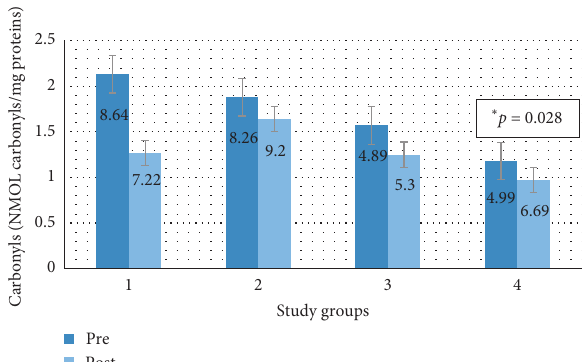
Figure 13: Medium pre-post carbonyls by study groups. Group 1: animals that maintained a steatotic diet and received concomitant treatment. Group 2: animals that maintained a steatotic diet and received no drug. Group 3: animals that did not continue with the steatotic diet but received melatonin treatment. Group 4: animals that did not continue with the steatotic diet and did not receive any